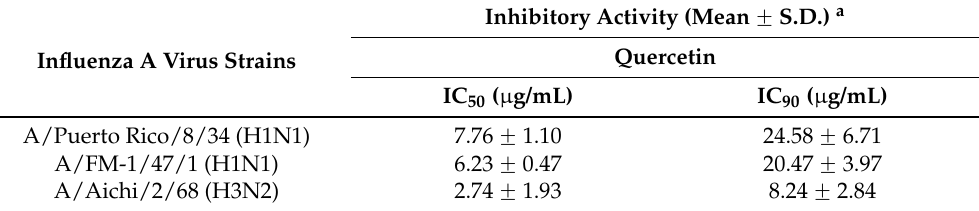
Table 1. IC 50 and IC 90 of quercetin against influenza A virus strains.